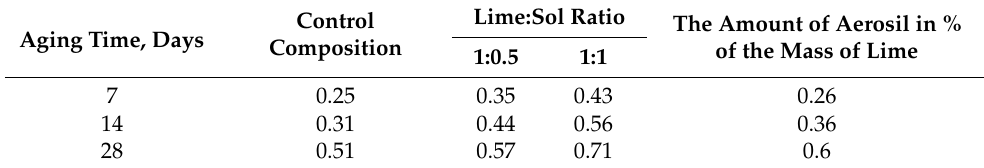
Table 6. Influence of additives on the compressive strength of lime compositions, MPa.